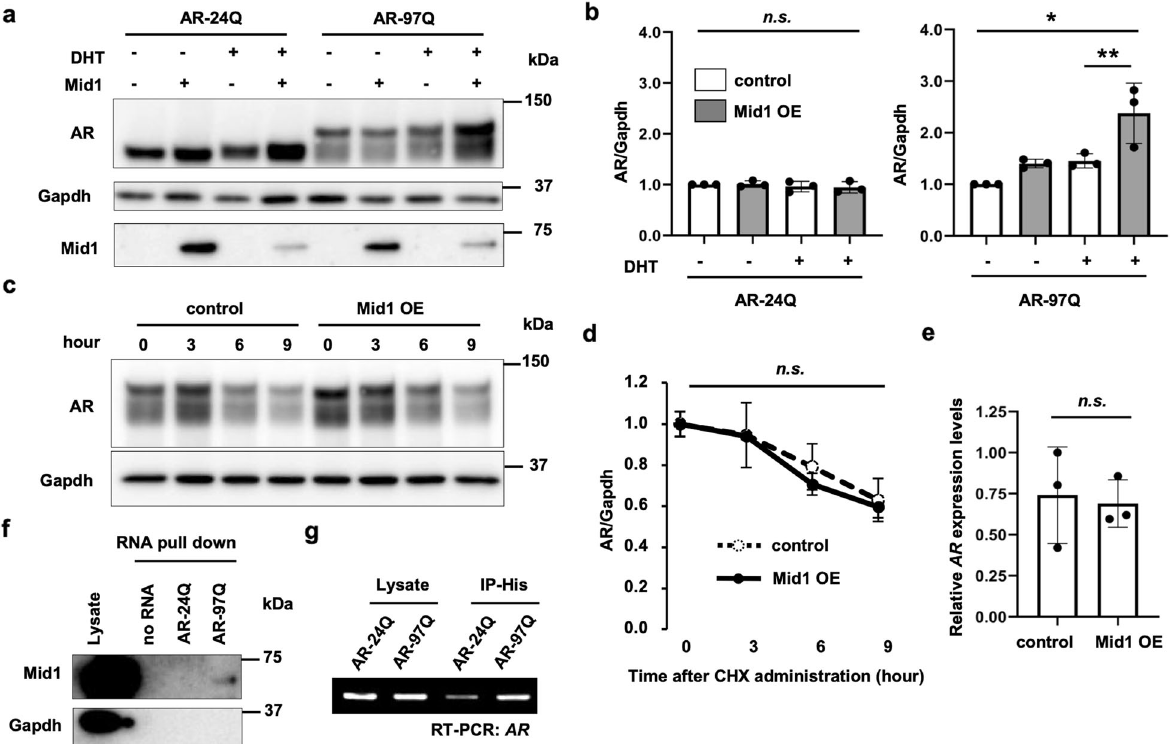
Fig. 2 Mid1-induction of pathogenic AR protein in an SBMA cellular model. a Immunoblots showing levels of human AR protein in NSC34 cells expressing AR-24Q or AR-97Q, which were cultured with or without DHT treatment and transfected with Mid1 -expressing or empty vector. b Quantitative densitometry analyses of human AR levels in a ( n = 3 samples per group). The data were normalized to the AR levels without DHT treatment and Mid1 transfection. Signi fi cant difference was detected by Tukey ’ s multiple comparisons test (* p < 0.005, ** p < 0.05) after one-way ANOVA (* p < 0.005 for AR-97Q samples). c Immunoblots showing the time course of human AR protein levels in NSC34 cells expressing AR-97Q and transfected either with Mid1 or empty vector. Hours after the administration of CHX are shown. d